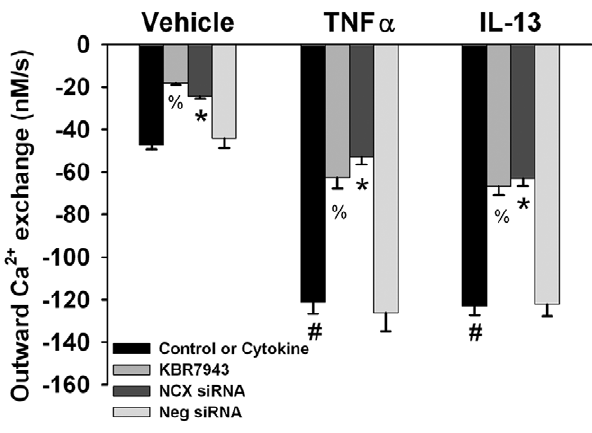
Figure 8. Effect of cytokines on outward Ca 2 + exchange via NCX in human ASM. In fura-2 loaded ASM cells where outward exchange mode NCX was evaluated using the protocol illustrated in Figure 7, KBR7943 as well as NCX1 siRNA (but not negative siRNA) substantially inhibited outward Ca 2 + exchange. Exposure to TNF a or IL- 13 (24 h) significantly enhanced outward exchange-mode NCX (compared to controls not exposed to cytokines). KBR7943 and NCX1 siRNA also prevented cytokine-mediated increase in outward Ca 2 + exchange. Values are means 6 SE (n=5 patient samples for controls, 3 patient samples for cytokine groups; minimum 60 cells per bar). % indicates significant KBR7943 effect, * significant NCX1 siRNA effect, and # significant cytokine effect (p , 0.05).